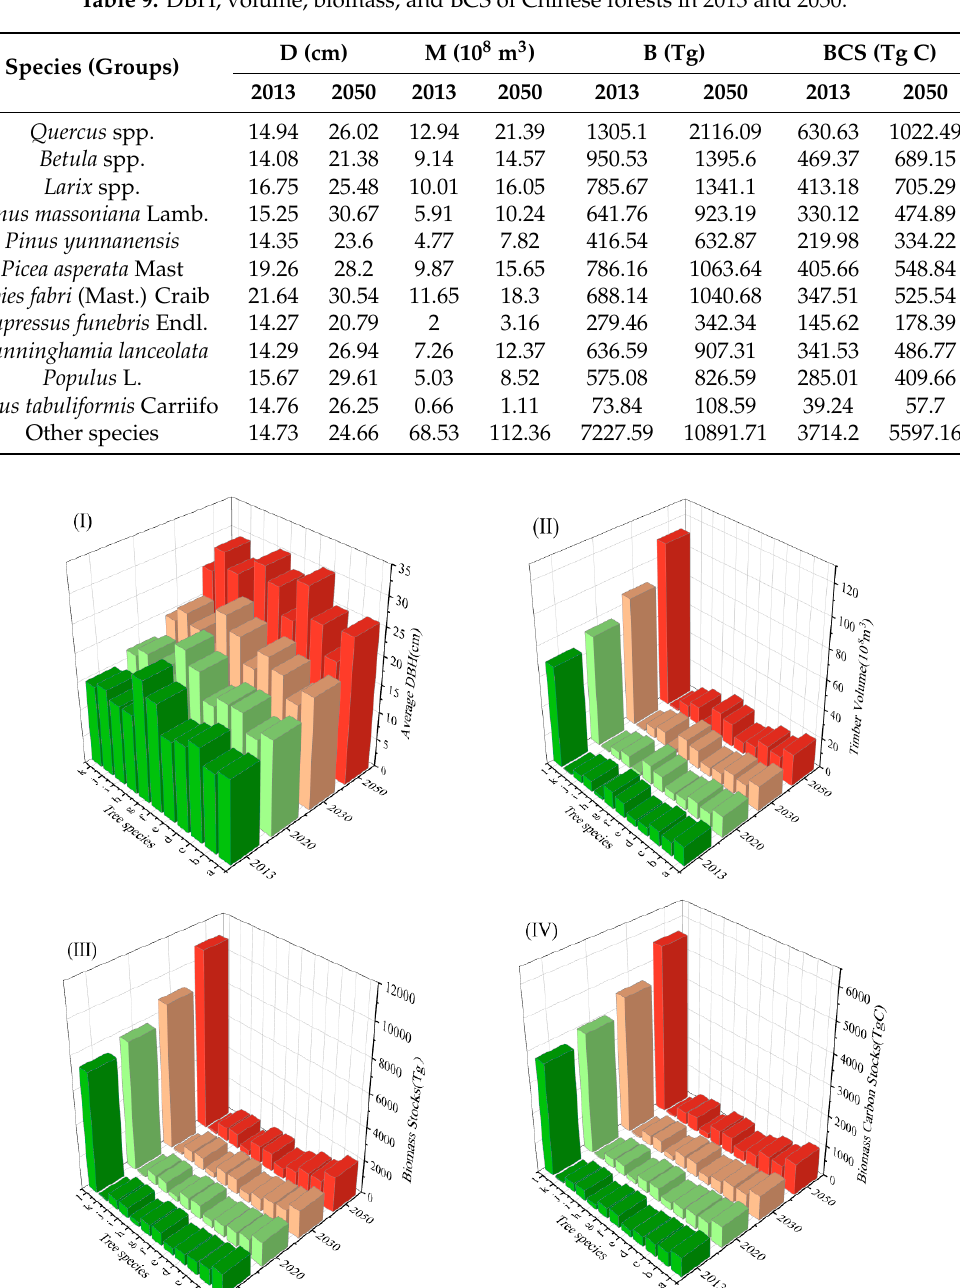
Table 9. DBH, volume, biomass, and BCS of Chinese forests in 2013 and 2050. Species (groups)